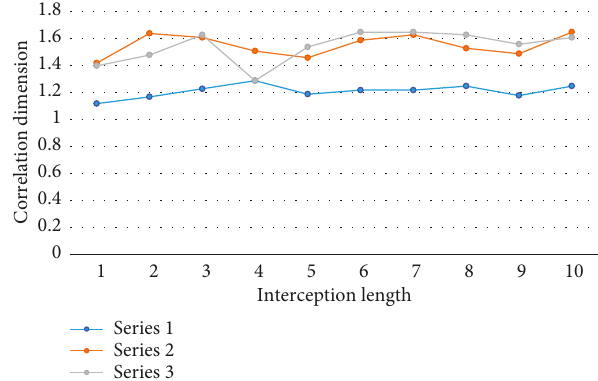
Figure 12: Correlation dimension values of vibration signals with different intercept lengths.